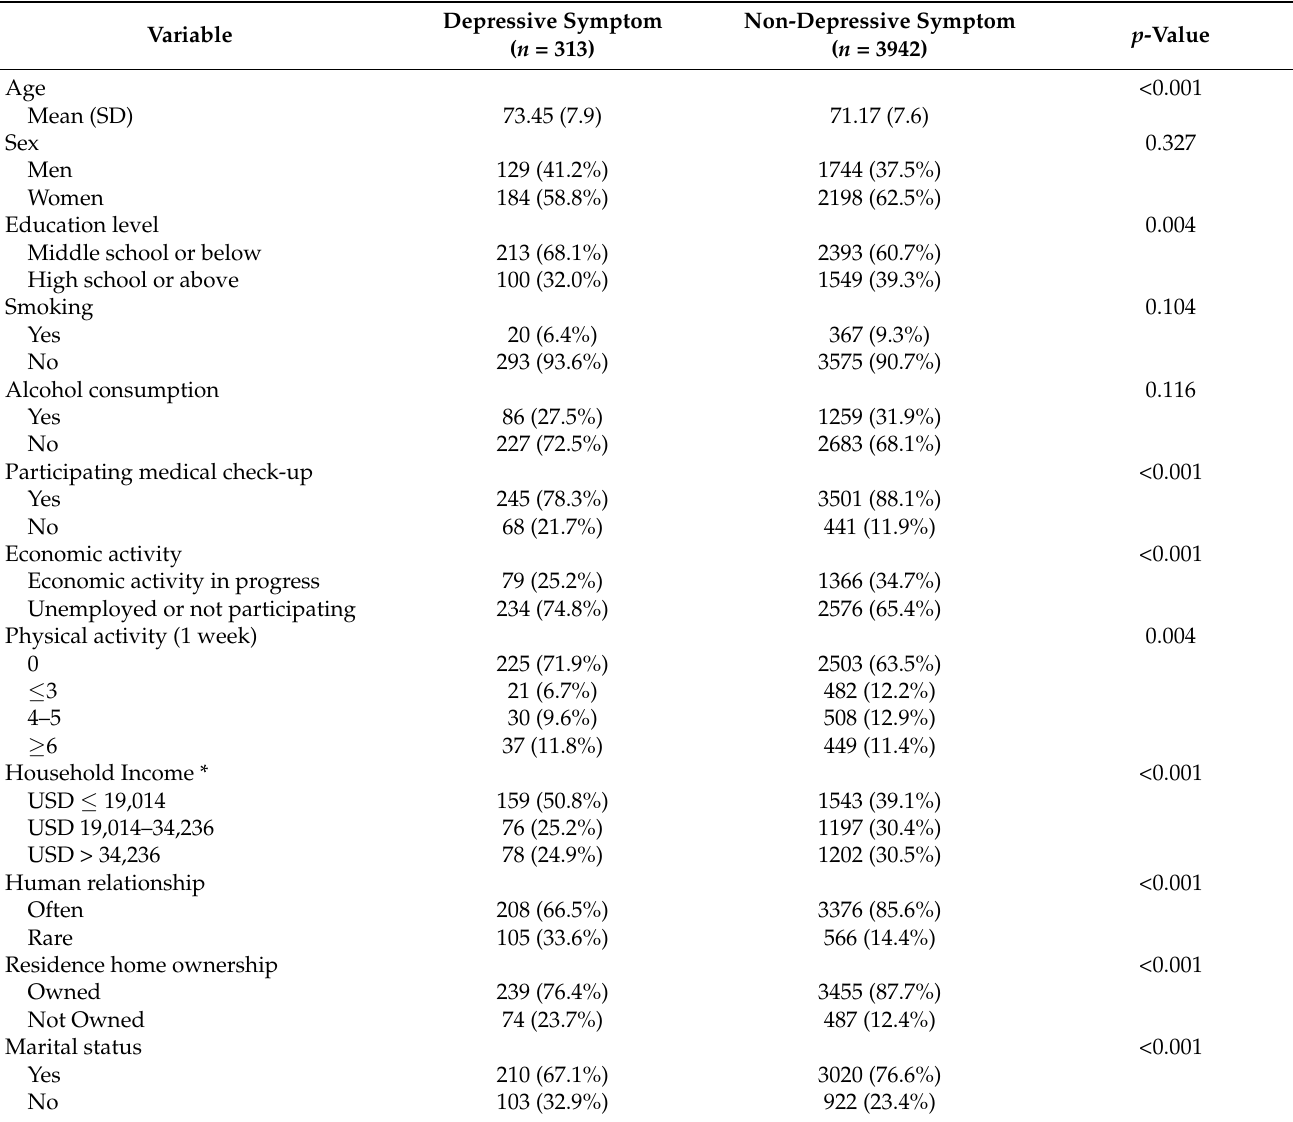
Table 1. Baseline characteristics of participants by new-onset of depressive